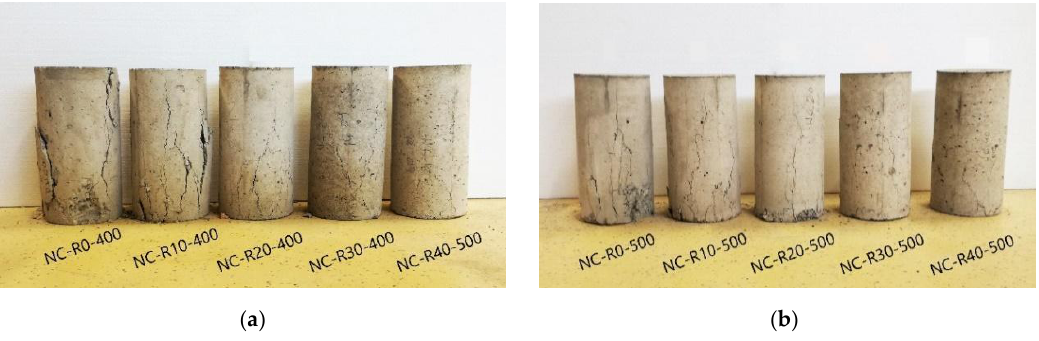
Figure 9. ( a ) Failure types of test specimens from Series I and ( b ) Series II.